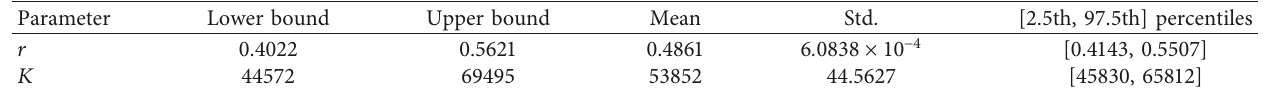
Figure 2: Parameter histograms of the Gompertz model of the IABC-SMC algorithm. (a) Estimation of r . (b) Estimation of K . Here, the � 5 , a � 0 . 4 ,T � 6 , and t � 12. initial states are n � 6000 ,x 0 Table 4: Parameter ranges and statistics of the Gompertz model.